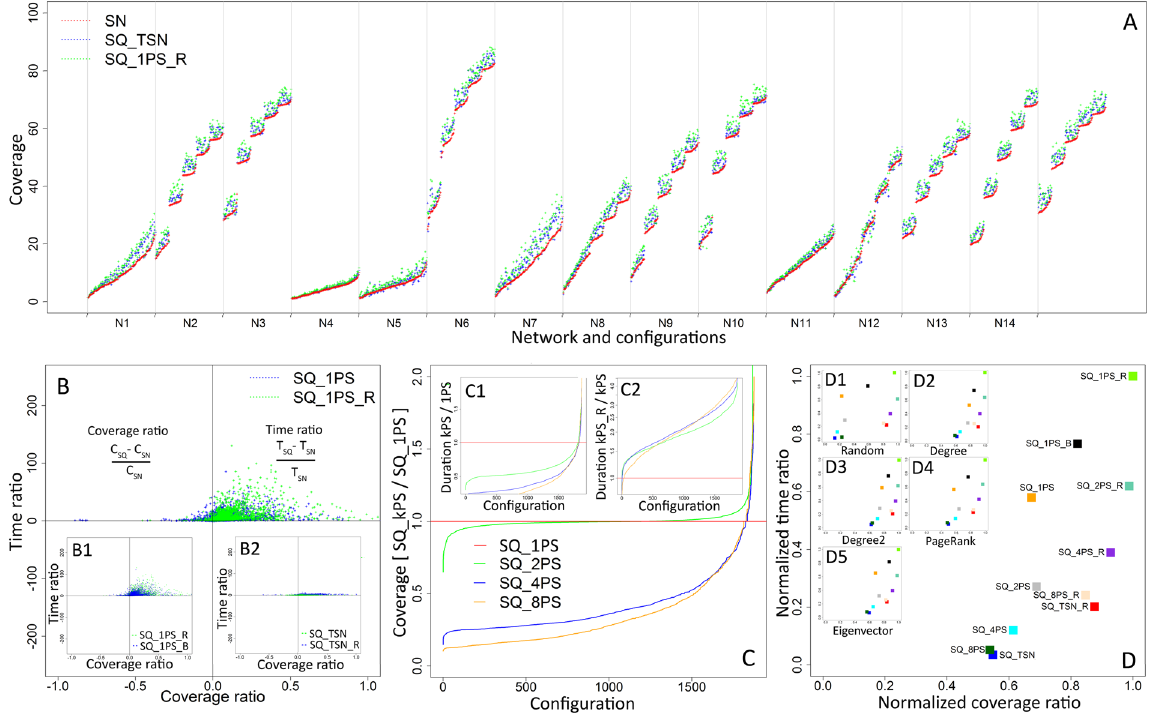
Figure 5. ( A ) Coverage for SQ_1PS_R and SQ_TSN compared with single stage (SN) individually for each network; ( B ) Speed and coverage ratios for one per stage strategy with (SQ_1PS_R) and without revival mode (SQ_1PS) in reference to single stage approach SN; T SQ , C SQ – time and coverage in suitable sequential seeding; ( B1 ) Time and coverage ratios for sequential strategy with revival SQ_1PS_R vs. sequential strategy with buffering SQ_1PS_B; ( B2 ) Reference based sequential strategy SQ_TSN vs. SQ_TSN_B; ( C ) Coverage ratios for SQ_kPS strategies with 2, 4 and 8 seeds per stage in relation to one per stage approach SQ_1PS; ( C1 ) Duration of diffusion for SQ_kPS strategies with 2, 4 and 8 seeds per stage in relation to one per stage approach SQ_1PS; ( C2 ) Duration of SQ_kPS_R strategies with revival in the relation to SQ_kPS without revival; ( D ) Normalized average time and coverage ratios for all used sequential strategies; ( D1 ) Normalized ratios for random (R) node ranking; ( D2 ) Normalized ratios for degree based ( D ) node ranking; ( D3 ) Normalized ratios for second level degree ( D2 ) based node ranking; ( D4 ) Normalized ratios for PageRank (PR) based node ranking; ( D5 ) Normalized ratios for eigenvector based node